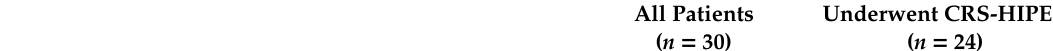
Table 1. Baseline characteristics of all patients in the study and the selection of patients that underwent Cytoreductive Surgery and Hyperthermic Intraperitoneal Chemotherapy (CRS-HIPEC).